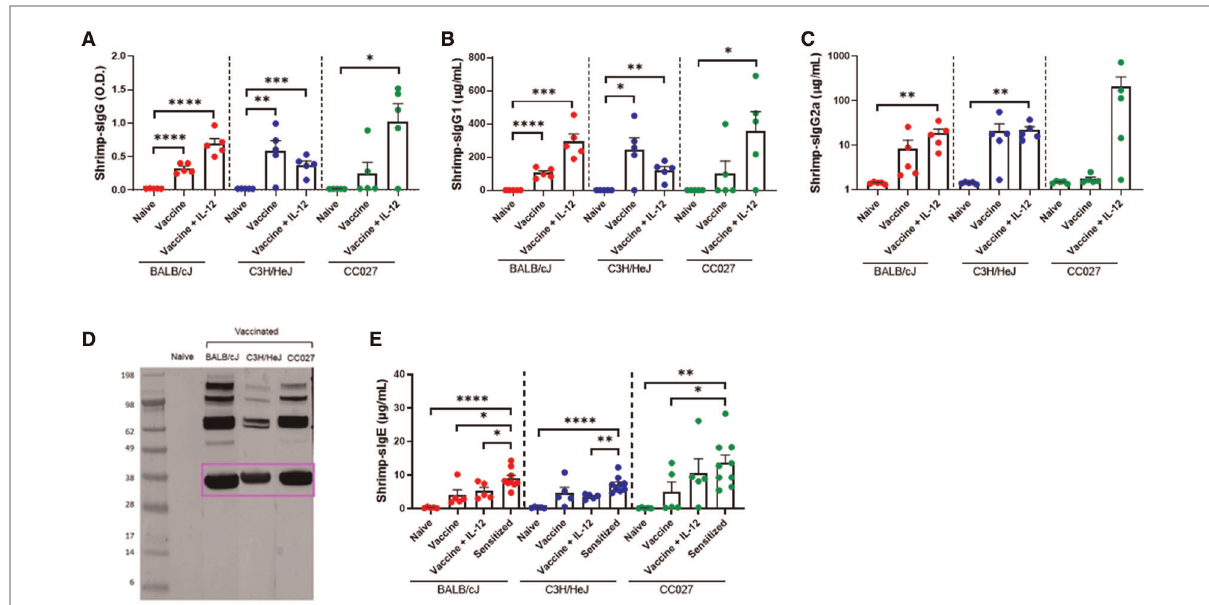
FIGURE 2 Shrimp-speci fi c immunoglobulin responses following DNA vaccination with Gene Gun. Shrimp-speci fi c ( A ) IgG, ( B ) IgG1, and ( C ) IgG2a in naïve and vaccinated BALB/cJ, C3H/HeJ and CC027 mice. ( D ) Western blot showing Gene Gun-vaccinated mice make shrimp-speci fi c IgG against the major shell fi sh allergen tropomyosin (purple box). ( E ) Shrimp-speci fi c IgE in naïve, vaccinated and sensitized BALB/cJ, C3H/HeJ, and CC027 mice. Statistical comparisons were made using unpaired t tests; * p <0.05, ** p <0.01, *** p <0.001, **** p